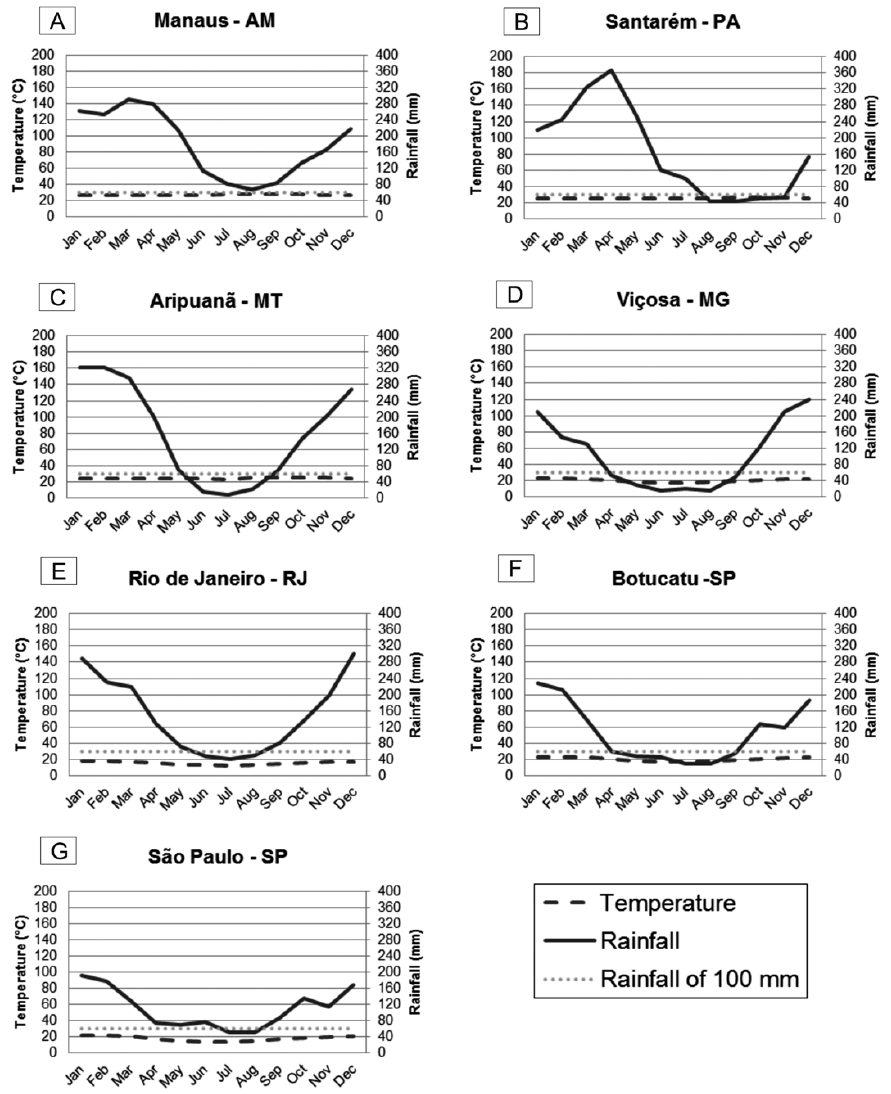
Figure 2 - Climatic diagrams of the seven study sites in which the studies of cambial activity were carried out (built from data obtained in DIVA Gis software Version 7.5). A: Manaus - AM. B: Santarém - PA. C: Aripuanã – MT. D: Viçosa - MG. E: Rio de Janeiro - RJ. F: Botucatu -